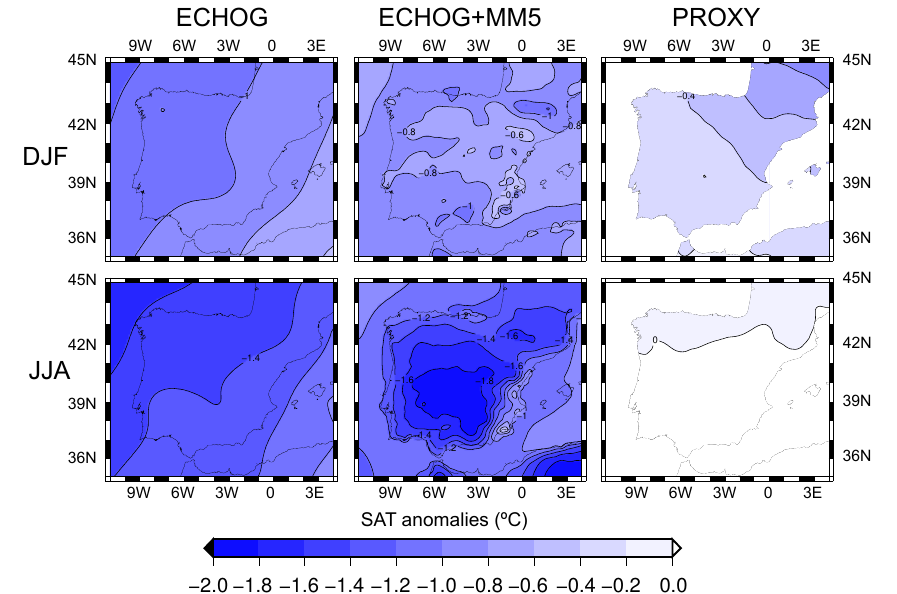
Fig. 12. SAT temperature anomalies for winter (top row) and summer (bottom row) in the 1671–1700 period with respect to 1900–1990. The figure shows the results for ECHO-G (left), ECHO-G+MM5 (centre), and the SAT reconstruction (right).